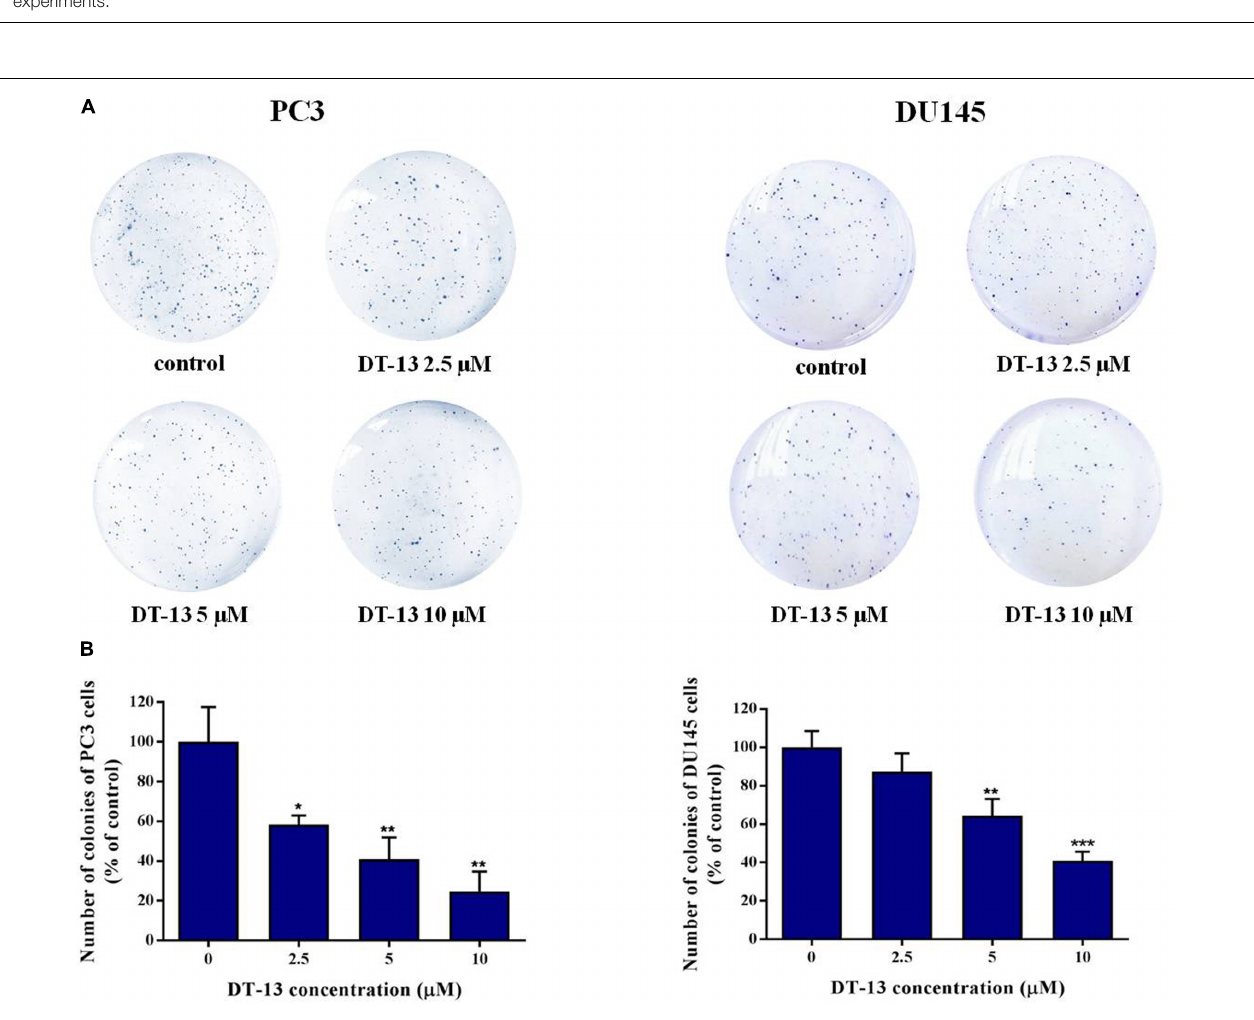
FIGURE 2 | Effect of DT-13 on colony formation capability of prostate cancer cells. (A) Clonogenic assay was carried out to assess the effect of DT-13 on the colony formation capability of PC3 and DU145 cells. After treatment with 0, 2.5, 5, and 10 mM of DT-13 for 48 h, cells were incubated in agarose plates for 14 days and then stained with crystal violet. (B) The histograms represent the number of colonies of PC3 and DU145 cells following treatment with DT-13, compared to those of control cells. Data are mean ± SD ( n = 3), representative of three independent experiments. ∗ P < 0.05, ∗∗ P < 0.01, ∗∗∗ P < 0.001, compared with control.